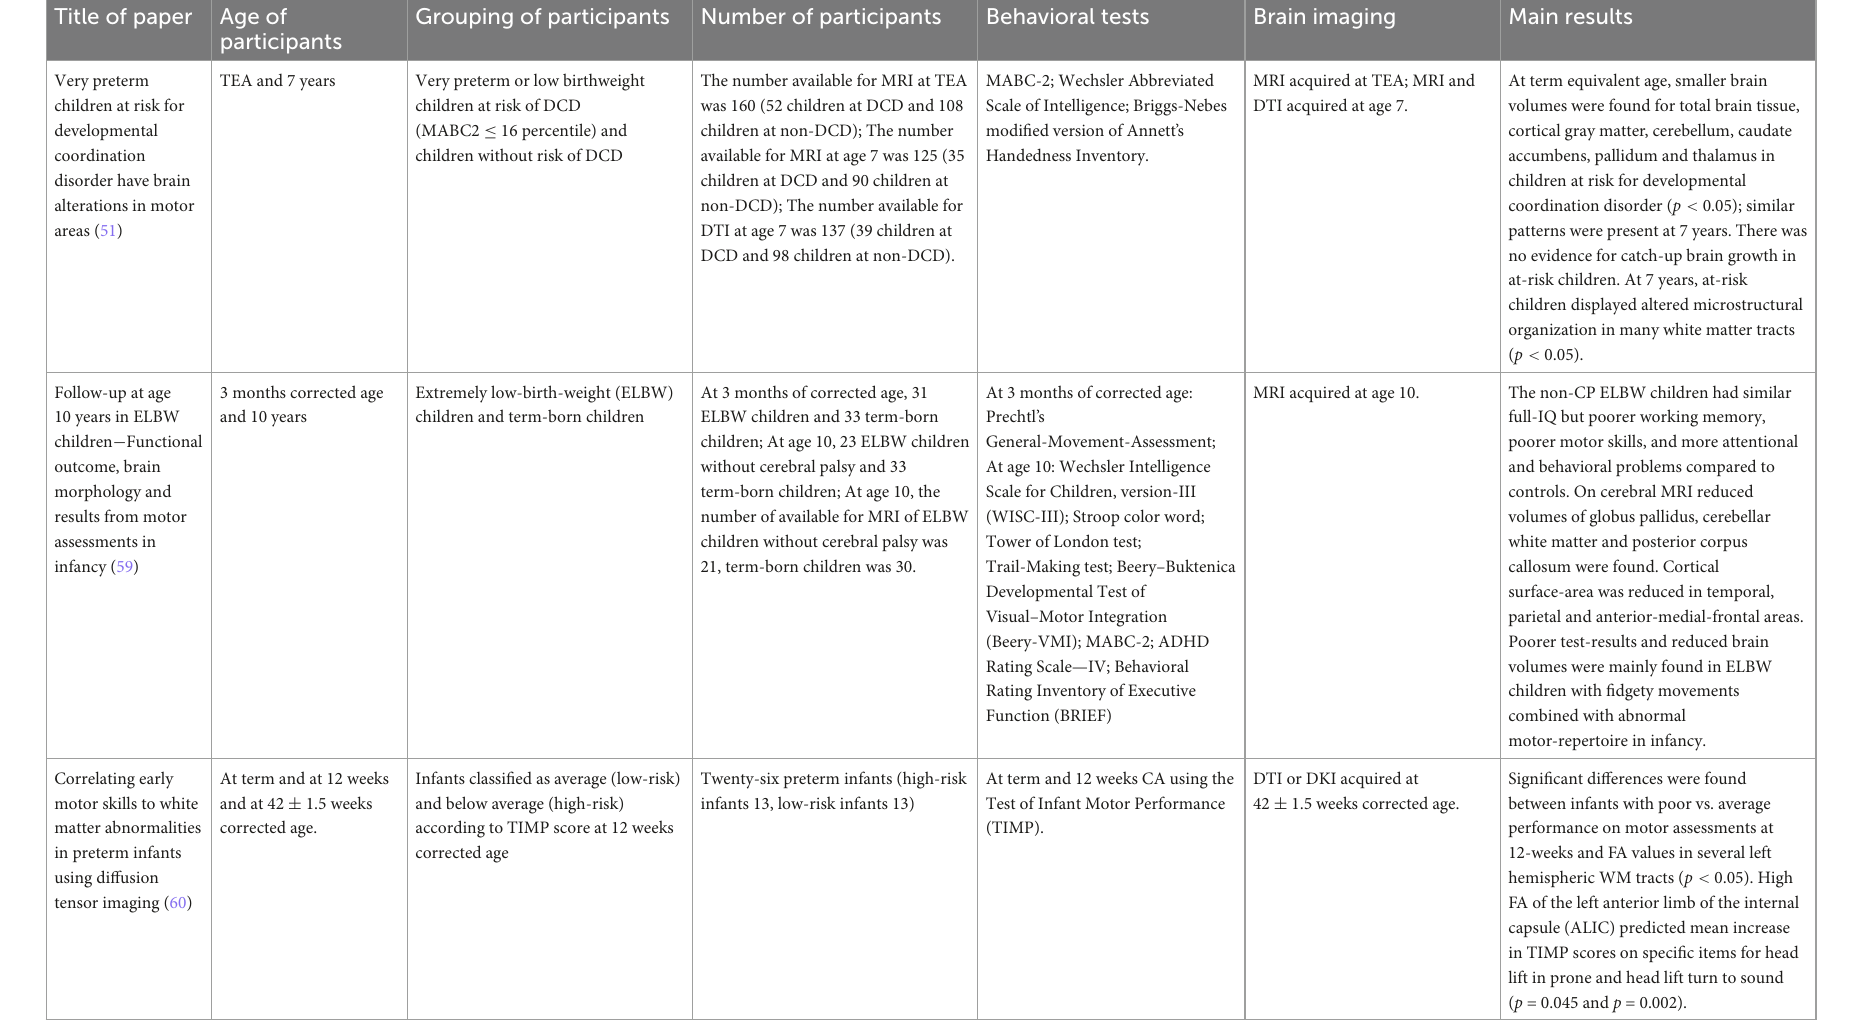
TABLE 3 Summary of five studies combining motor, perinatal, and brain